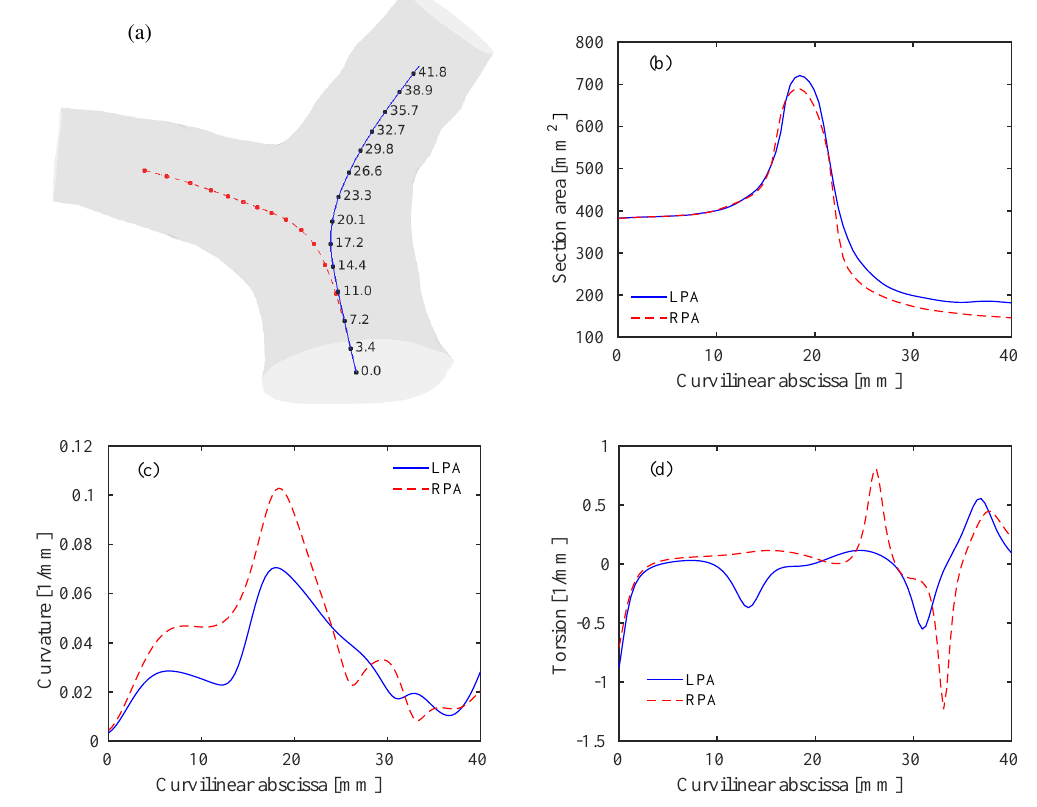
Figure 4. Geometry of the pulmonary bifurcation model. ( a ) Template model including left pulmonary arteries (LPA) (blue) and right pulmonary arteries (RPA) (red) centerlines. Values of the curvilinear abscissa (in mm) are also reported for the LPA at several discrete points. Note that the values for the RPA are the same at the corresponding points. ( b ) Areas of the lumen sections along the curvilinear abscissa for the LPA and RPA. ( c ) Curvature of the LPA and RPA centerlines. ( d ) Torsion of the LPA and RPA